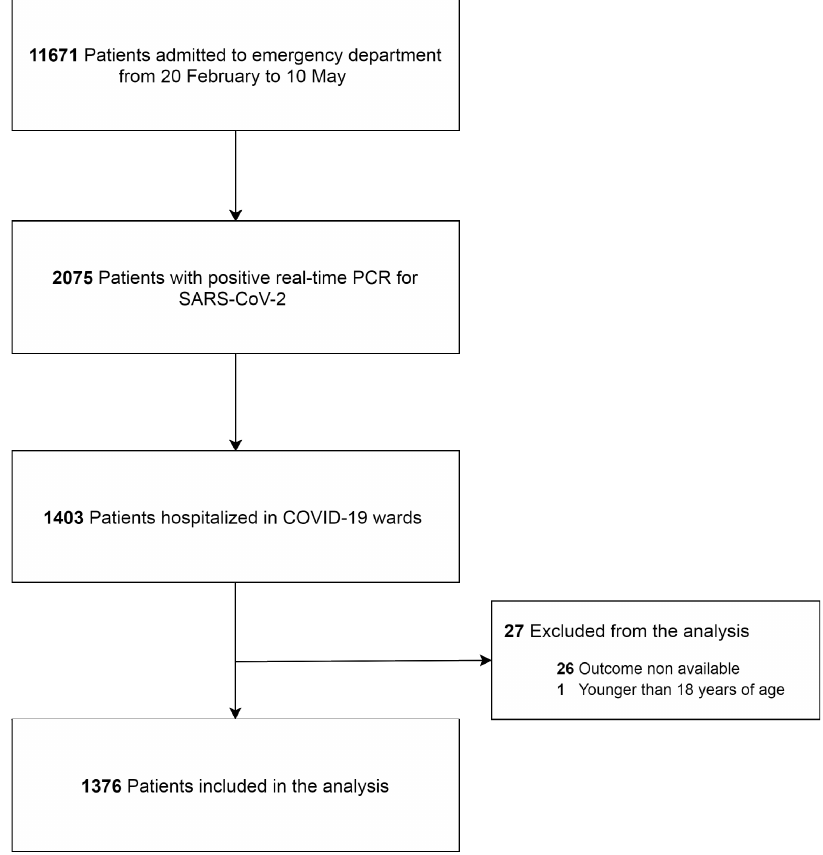
Figure 1. Severe acute respiratory syndrome coronavirus 2 (SARS-CoV 2). Coronavirus disease (COVID-19). Figure SEQ Figure\* ARABIC 1.